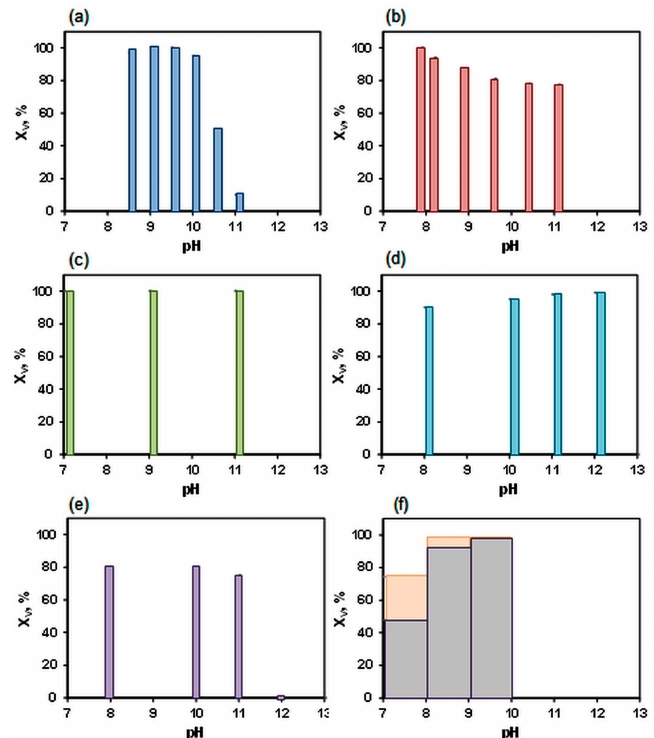
Figure 4. Influence of pH on vaterite concentration in CaCO 3 samples; (a) ) L-L, S = 6.5, t = 24 °C, based on data from [21]; (b) G-L, [Ca 2+ ] = 0.1 M, t = 20 °C, V G = 18 dm 3 /h, x CO2 = 033, based on data from [55]; (c) L-L, [Ca 2+ ] = 0.5 M, t a , with ILS, based on data from [75]; (d); L-L, [Ca 2+ ]:[CO 32 − ] = 1:3, t = 23 °C, with ethylene glycol, based on data from [74]; (e) L-L, [Ca 2+ ]:[CO 32 − ] = 1:1, t = 23 °C, with ethylene glycol, based on data from [74]; (f) G-L, t = 25 °C, x CO2 = 1, V G = 50 dm 3 /h (gray), V G = 100 dm 3 /h (orange), based on data from [59].